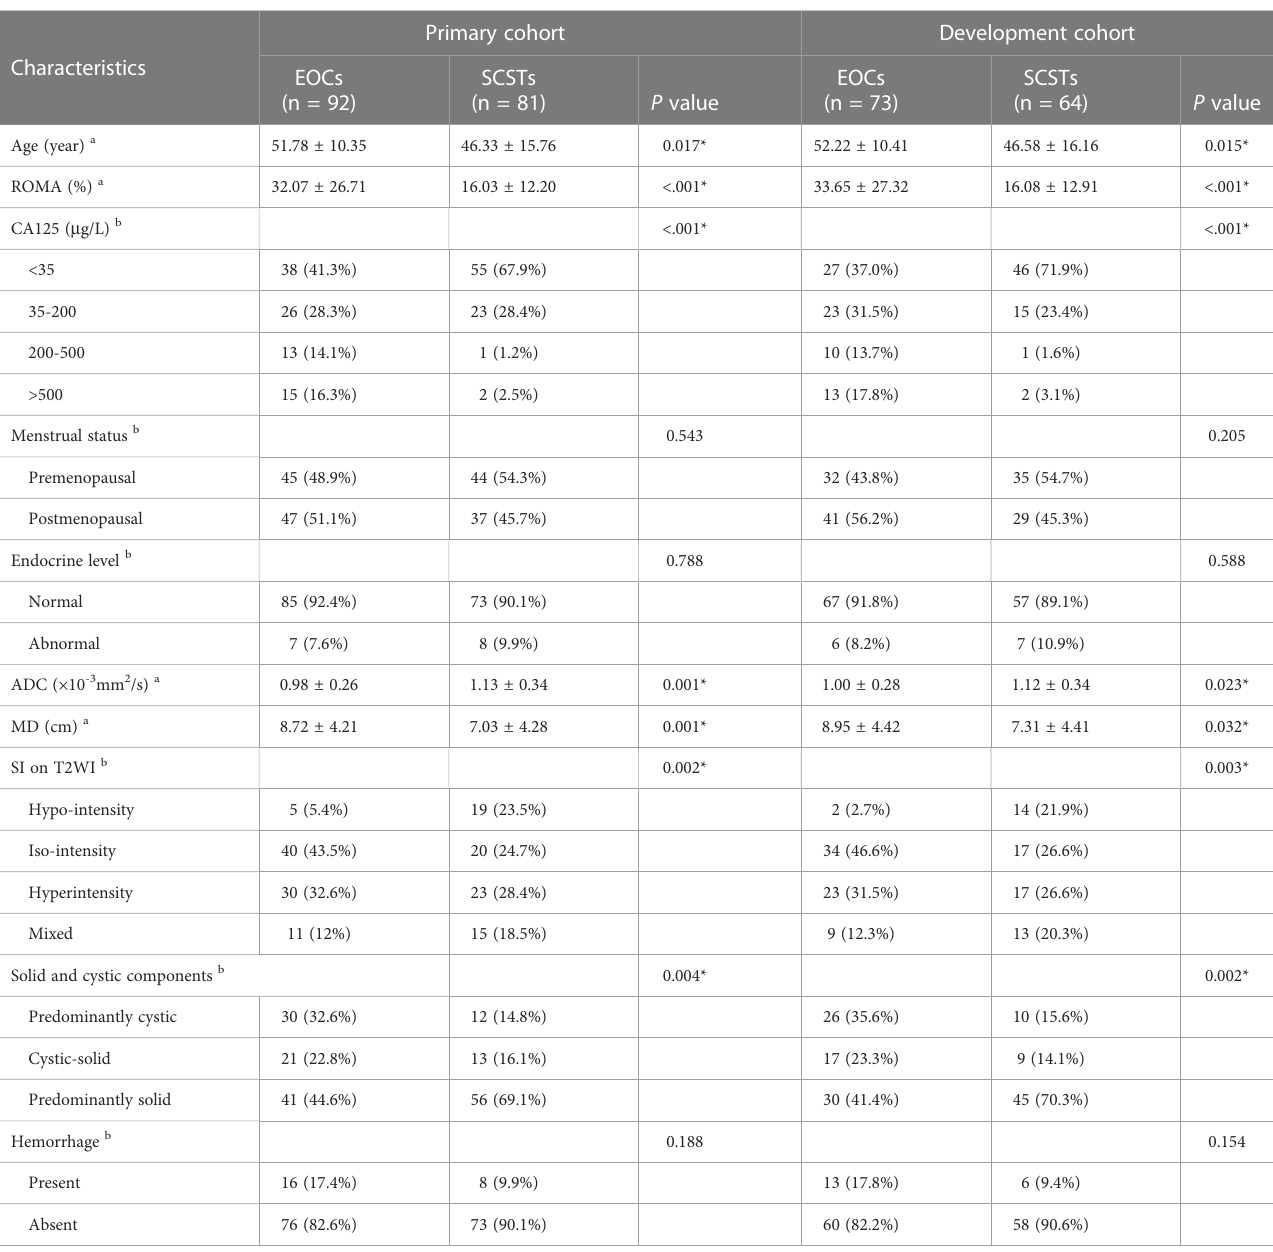
TABLE 2 The clinical data and MR parameters of the primary and development cohorts.